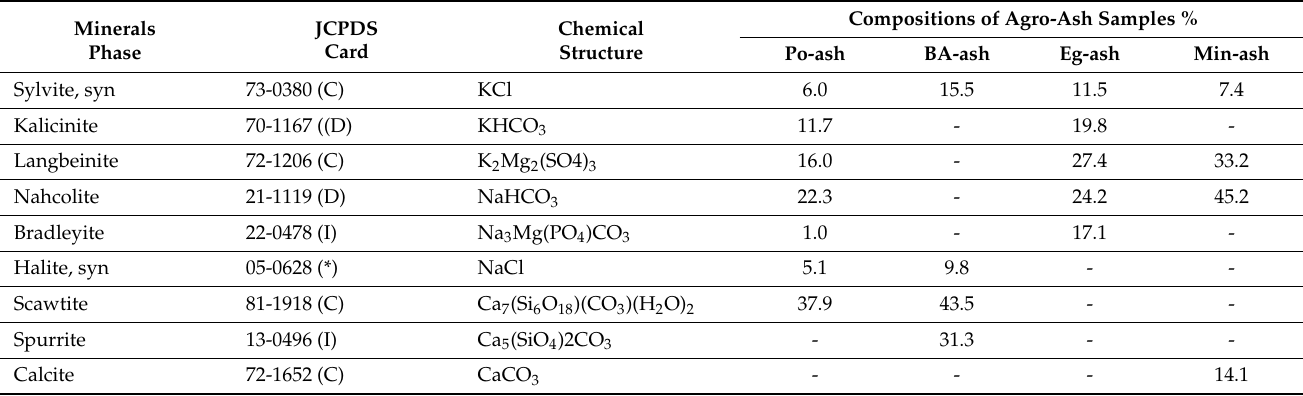
Table 1. XRD analysis of the constitutions of the tested agro-ashes, (Po-ash is Potato peel Ash, BA-ash is Banana peel Ash, Eg-Ash is Eggplant ash, and Min-Ash is Mint stem ash).